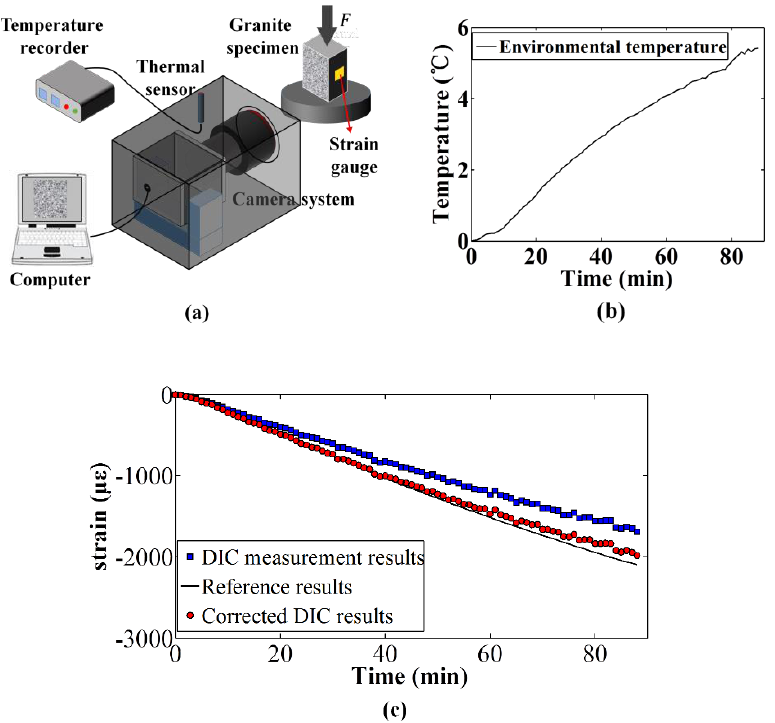
Figure 12. Experimental verification of model compensation method for compensating strain measurement error: ( a ) experimental arrangement, ( b ) environmental temperature during experiment, and ( c ) experimental